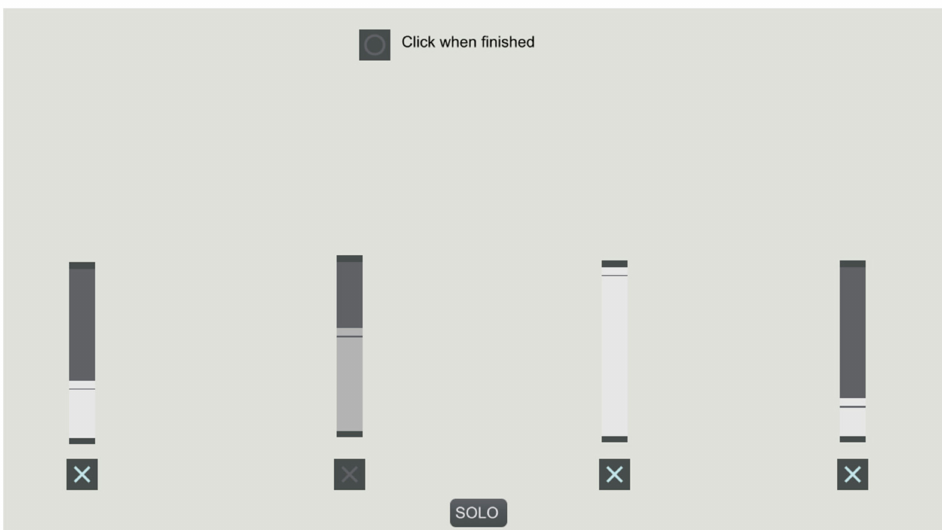
Figure 1. Screenshot of the mixing interface. Sliders from left to right were a ff ecting Slope, OER (odd / even ratio), Distortion, Inharmonicity. The ‘X’ buttons below the sliders toggle the sliders’ output between zero and its’ set value for an easy A / B comparison to the start